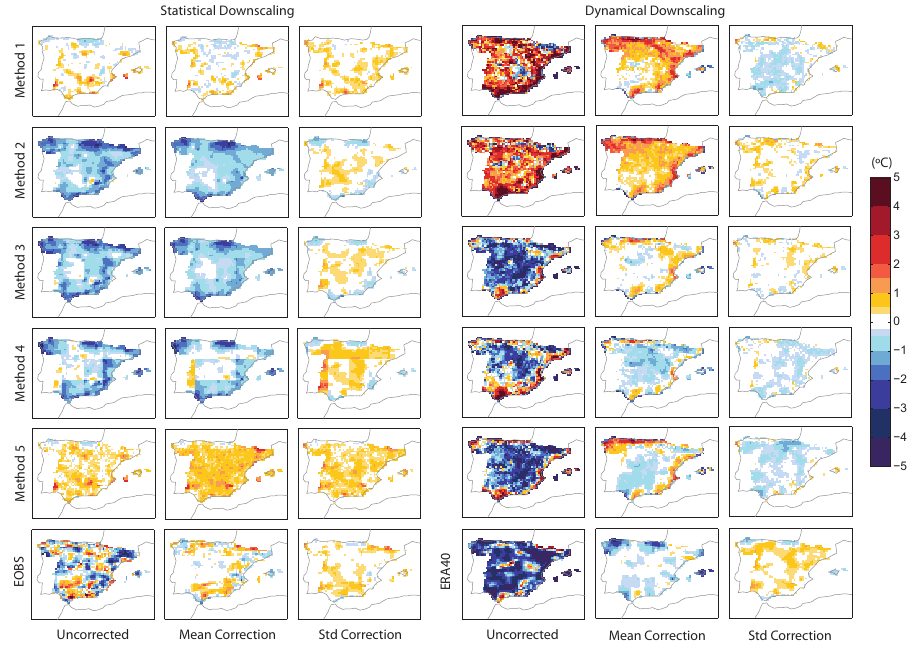
Fig. 4. Spatial bias distribution (in ◦ C) for the 95th percentile of daily maximum temperature for statistical (left panel) and dynamical (right panel) methods with respect to Spain02 in summer. The first column of each panel represent the bias without doing any correction. The second column represents the bias when the correction in the seasonal mean is done. The third column represents the bias when the second-order correction is done. E-OBS and ERA-40 biases with respect Spain02 are also included in the last